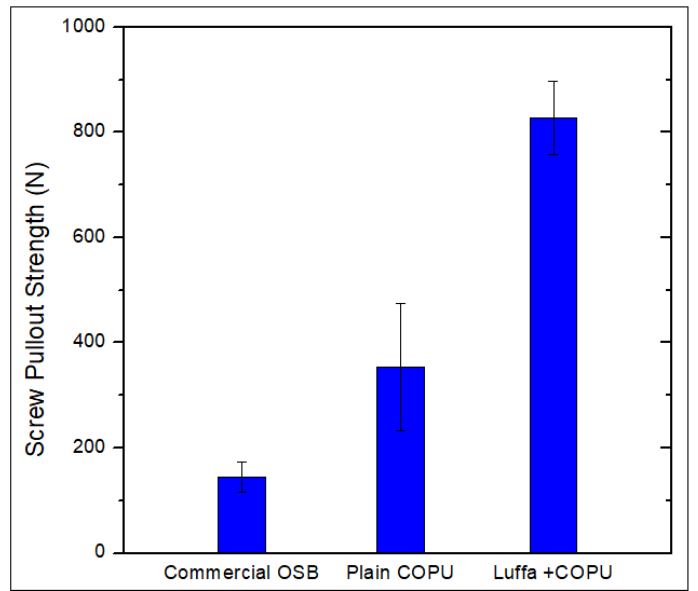
Figure 4. Screw pullout strength